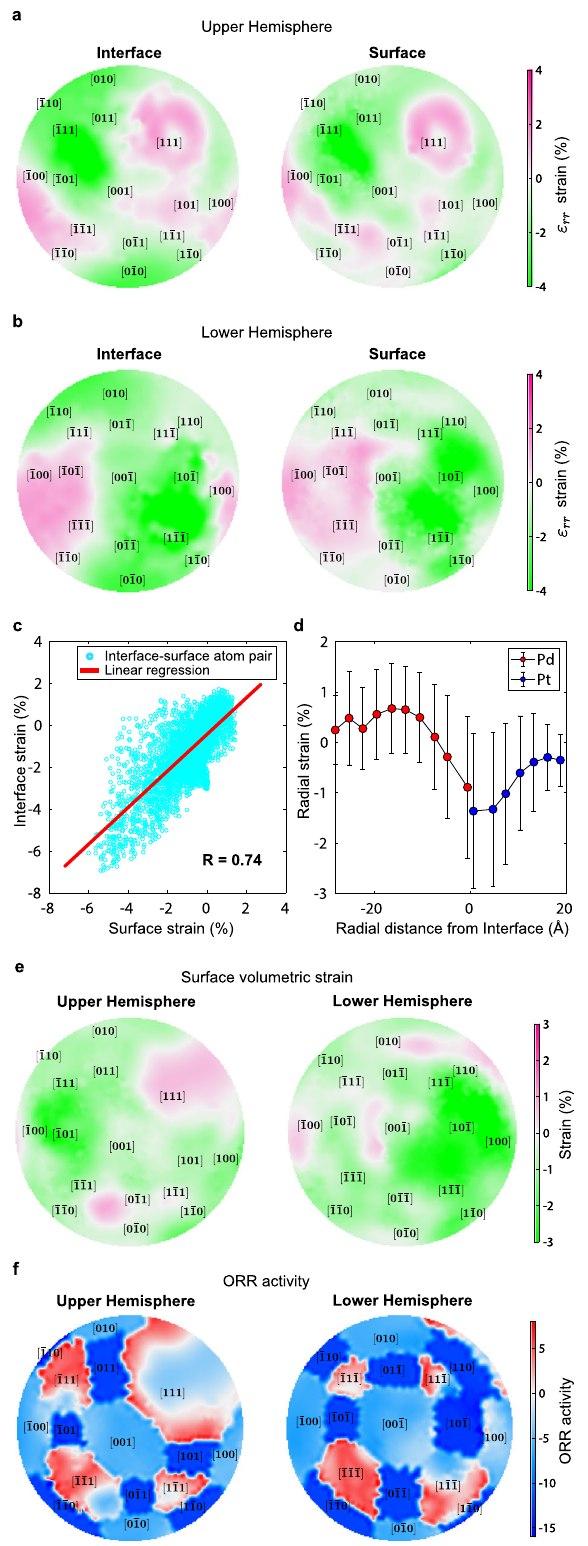
Fig. 3 | Surface and interface strain behavior, radial strain pro fi le, and surface ORR activity. a – b Pole fi gures obtained from stereographic projections of the radial strain at the interface and surface for the upper ( a ), and lower ( b ) hemi- spheres, respectively. The Miller indices of low-index facets are marked at the averagepositionofthesurfaceatomsassignedtoeachfacet(Methods). c Ascatter plot showing the relation between the observed radial strains of surface and interface atoms. Each data point was obtained by paring each interface atom with the corresponding surface atom along the radial direction (Methods). A Pearson correlation coef fi cient (R) of 0.74 and slope of 0.87 were obtained from a linear regression (red line). d The radial strain plotted as a function of the distance from the interface. Each data point and error bar represent an average and standard deviation of the strain values within the bins of 3 Å distance interval, respectively. e Pole fi guresobtained bystereographicprojectionsof thevolumetricstrainatthe surface for the upper and lower hemispheres. f Pole fi gures obtained from ste- reographic projections of the surface ORR activity for the upper and lower hemi- spheres. The ORR activity is represented as ln ( j / j Pt,(111) ) where j is the current density.TheMillerindicesoflow-indexfacetsaremarkedattheaveragepositionof the surface atoms assigned to each facet (Methods). Source data of c and d are provided as a Source Data fi